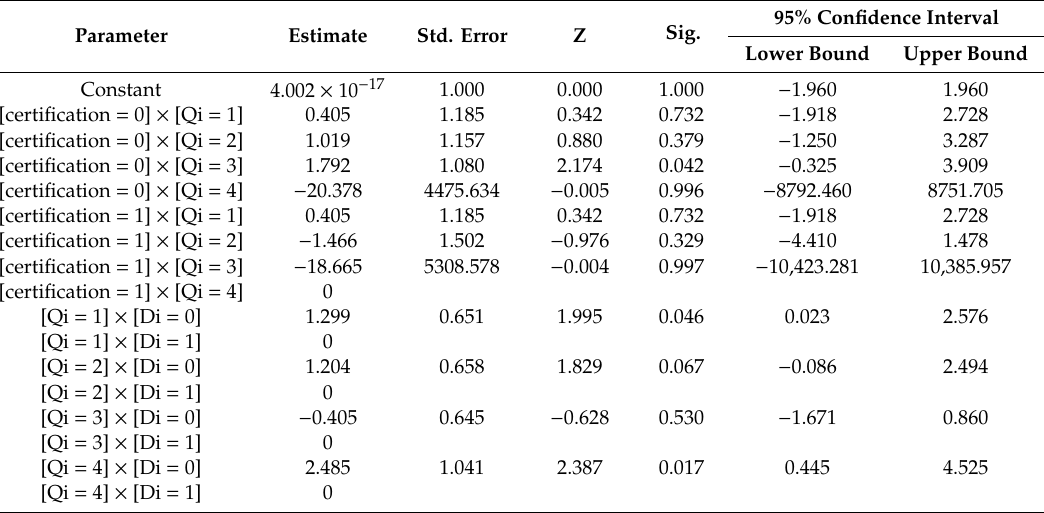
Table 7. Model parameter